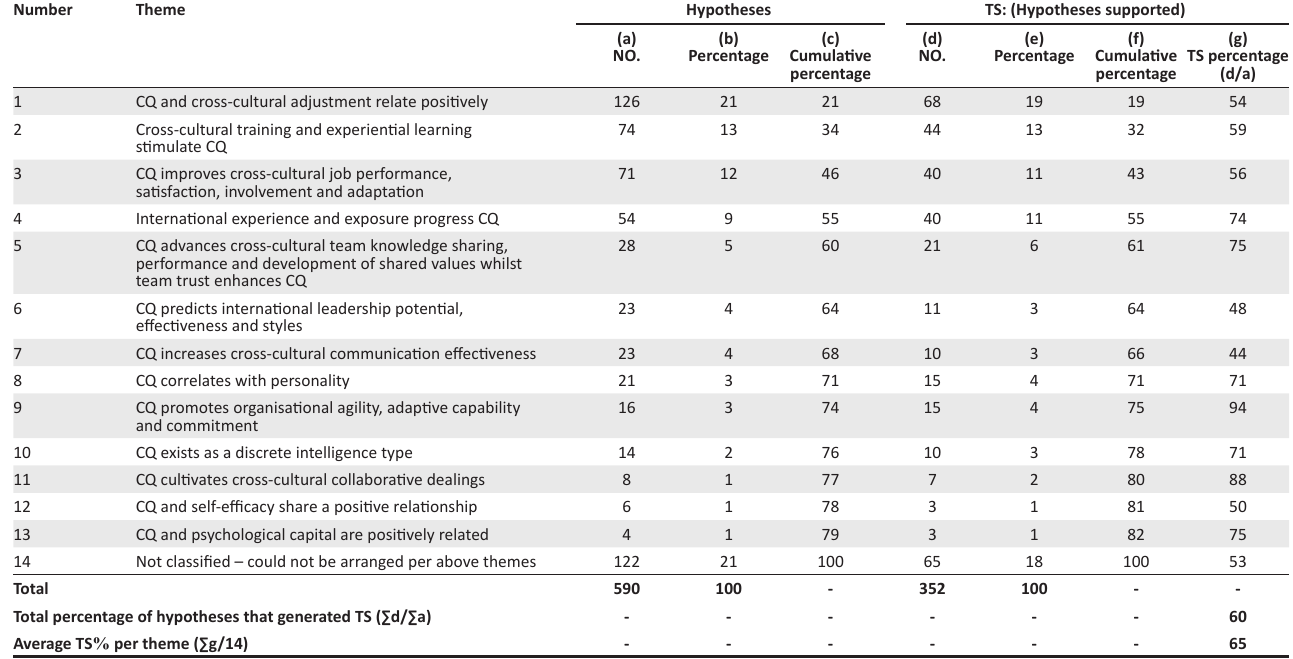
TABLE 1: Cultural intelligence hypotheses and truth statements per identified theme. Number Theme